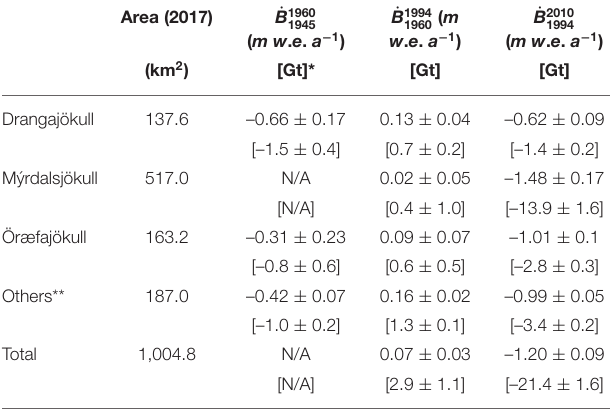
TABLE 3 | Mass changes of 14 Icelandic glaciers from 1945–1960 to